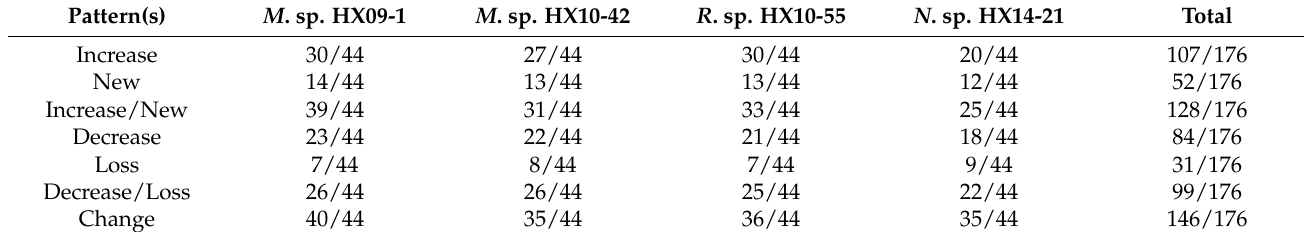
new activities and the other 6 pairs showing improved activities. Intriguingly, no decrease or loss of pre-existing antimicrobial activities was observed in the co-cultures. Table 1. Proportions of different change patterns in SM profiles of the co-cultures compared to the pure culture counterparts. The numbers represent the number of co-culture pairs.